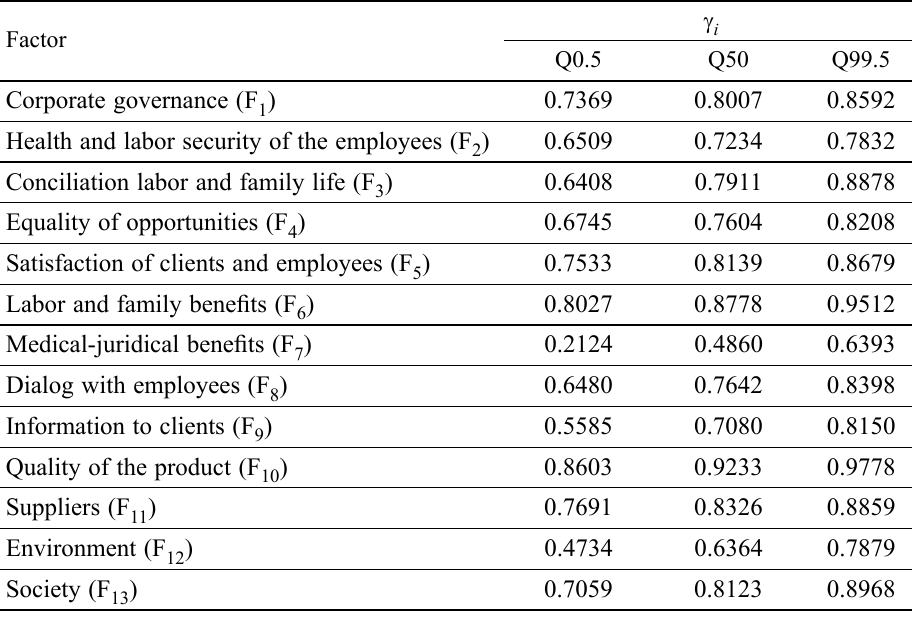
Table 2. Estimation of the parameters of the structural